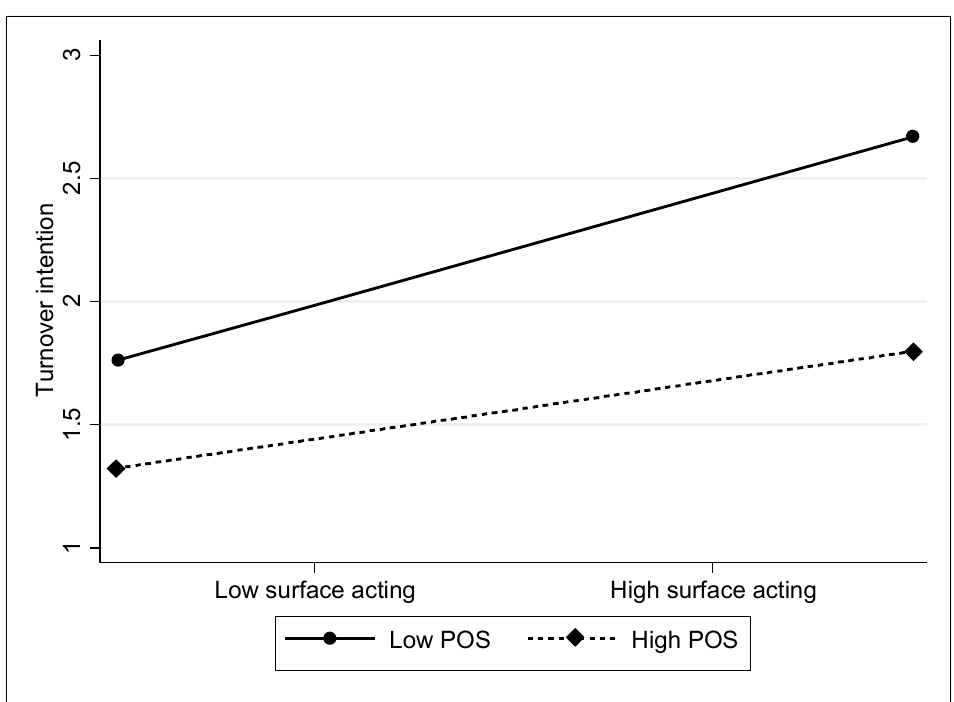
Figure 1. Moderating effect of POS on the relationship between surface acting and turnover intention.